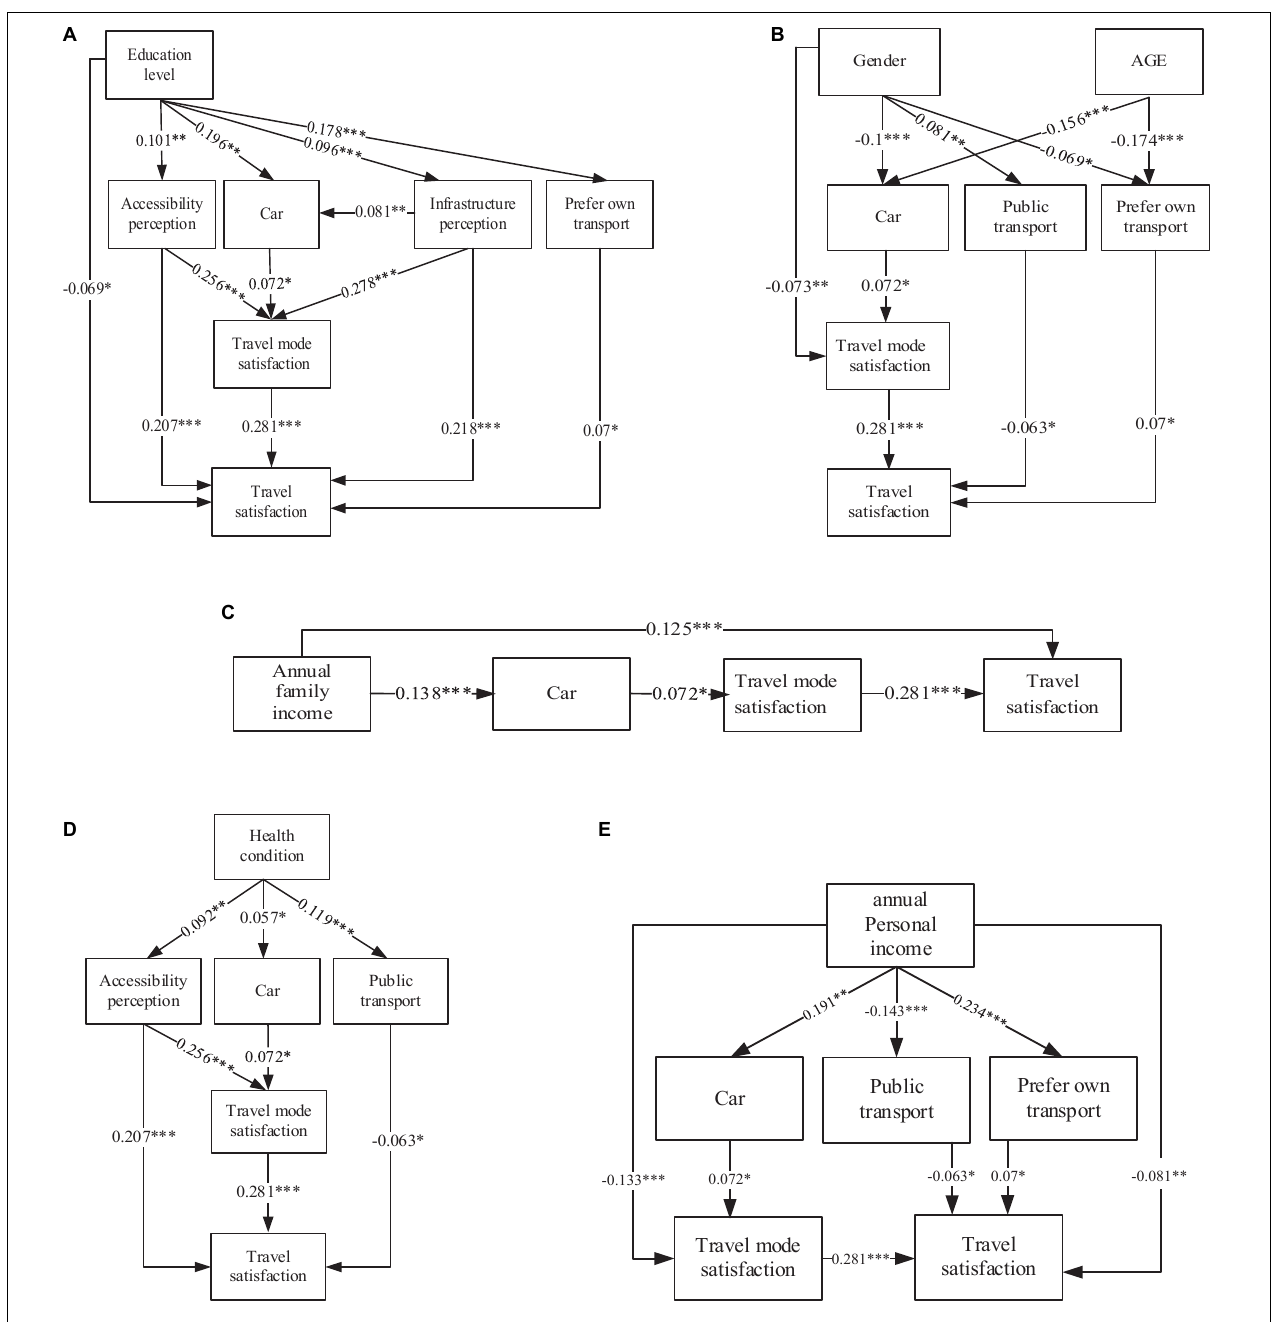
FIGURE 7 | (A) Education level. (B) Gender and age. (C) Annual family income. (D) Health condition. (E) Annual personal income. ***Represents p value < 0.01, **Represents p value < 0.05, and *Represents p value <